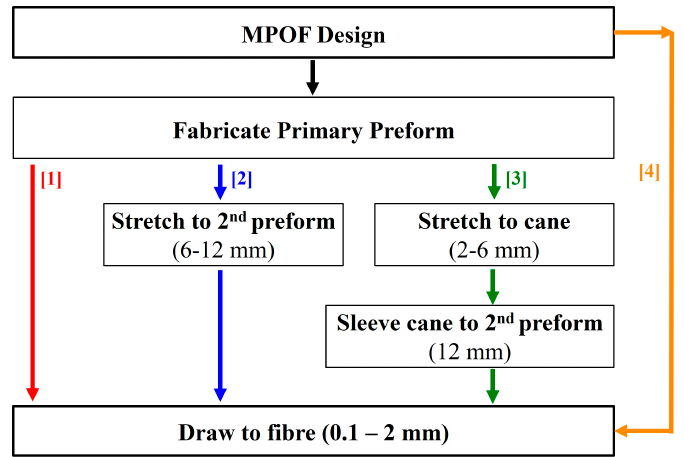
Figure 1. Schematic of microstructured polymer fiber fabrication, showing the three mains fabrication procedures and one new fabrication procedure.